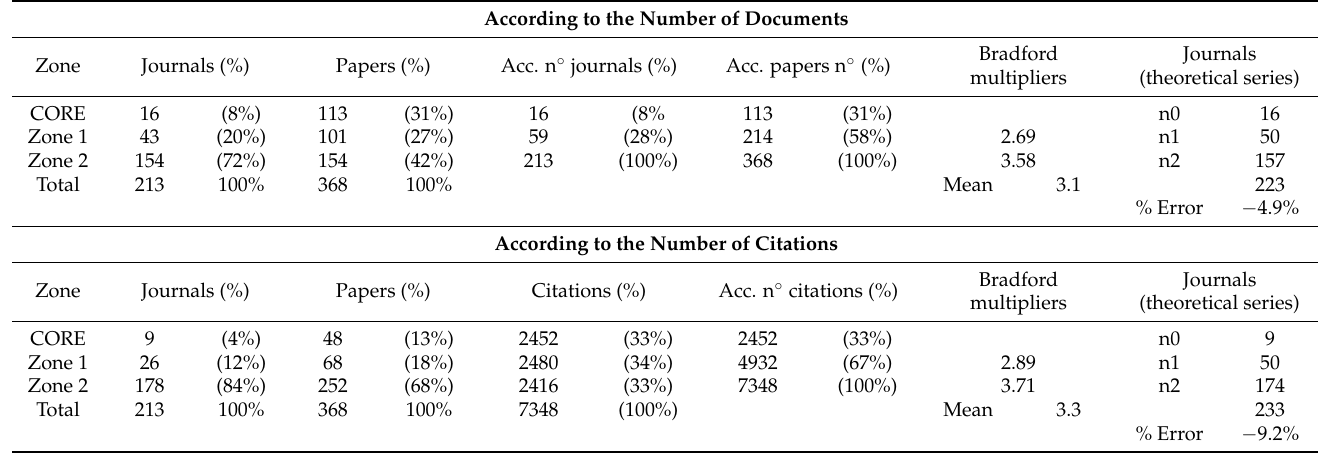
Table 3. Bradford’s zones and their number of journals, based on the number of